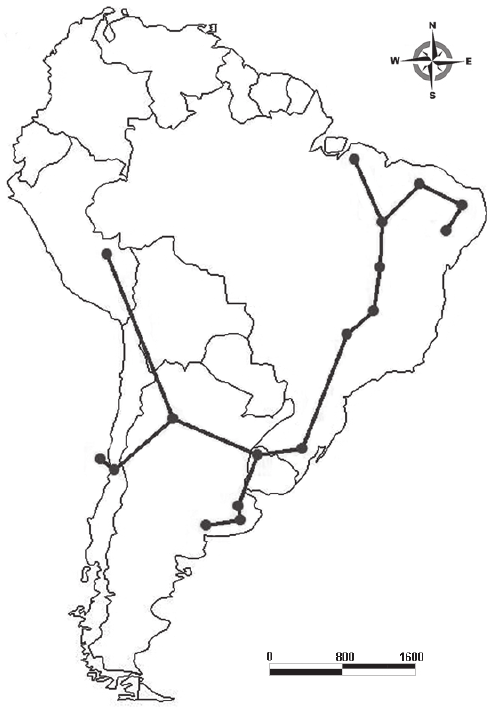
Fig. 11 - Individual track of Lestodon armatus. Fig. 9 - Individual track of Hippidion devillei.